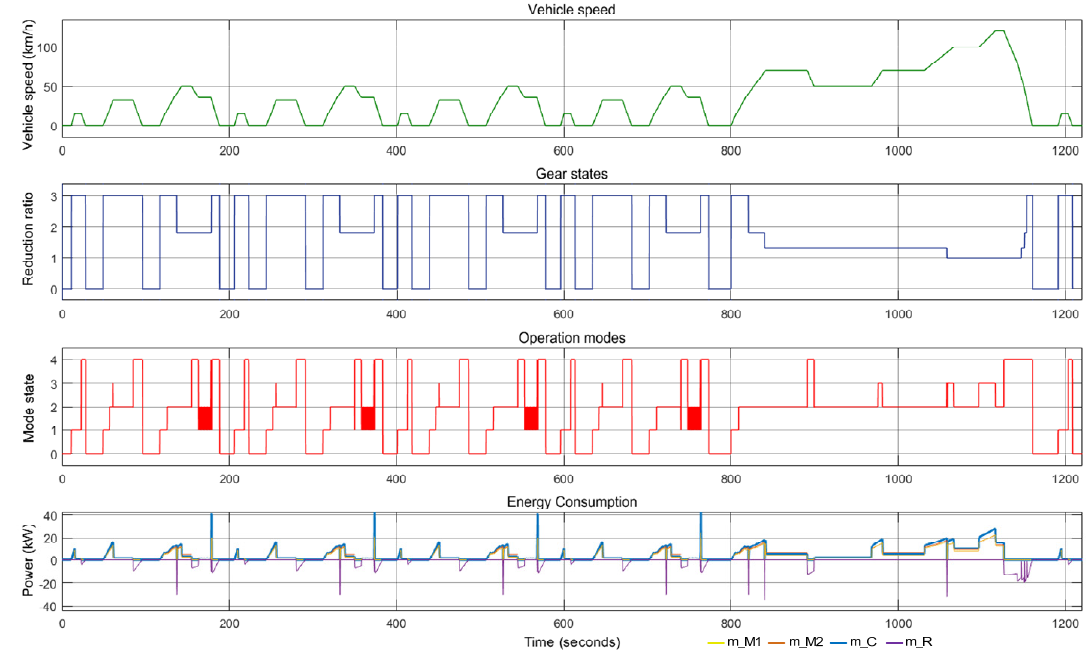
Figure 14. The simulation results of No. 6.